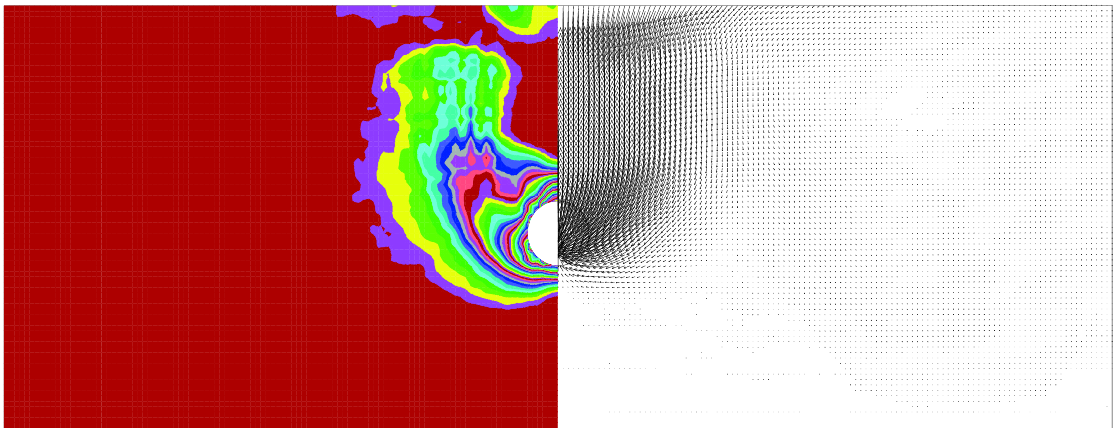
Figure 10. Shear strain rate (SSR) and velocity plot for C/D = 1, γD/S u = 5.